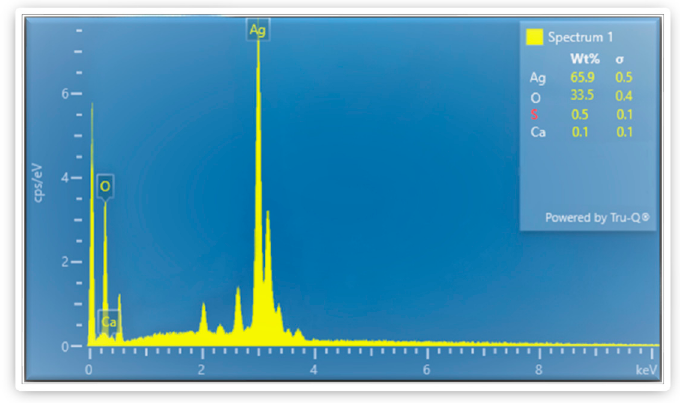
Figure 7. Elemental composition of Ag 2 ONPs using EDX.